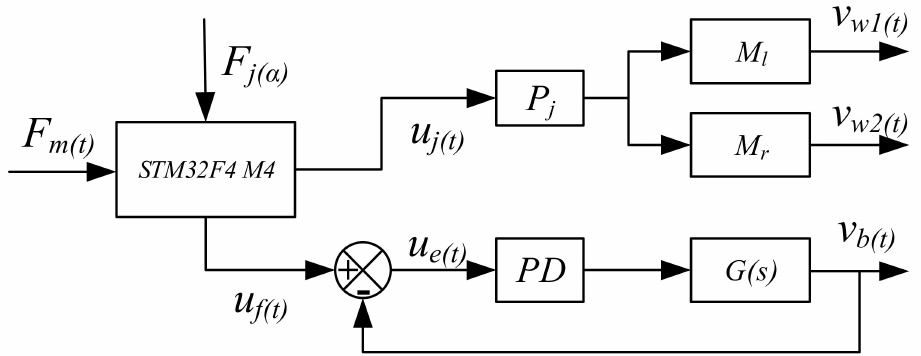
Figure 4. Control design scheme of leg exoskeleton assisted